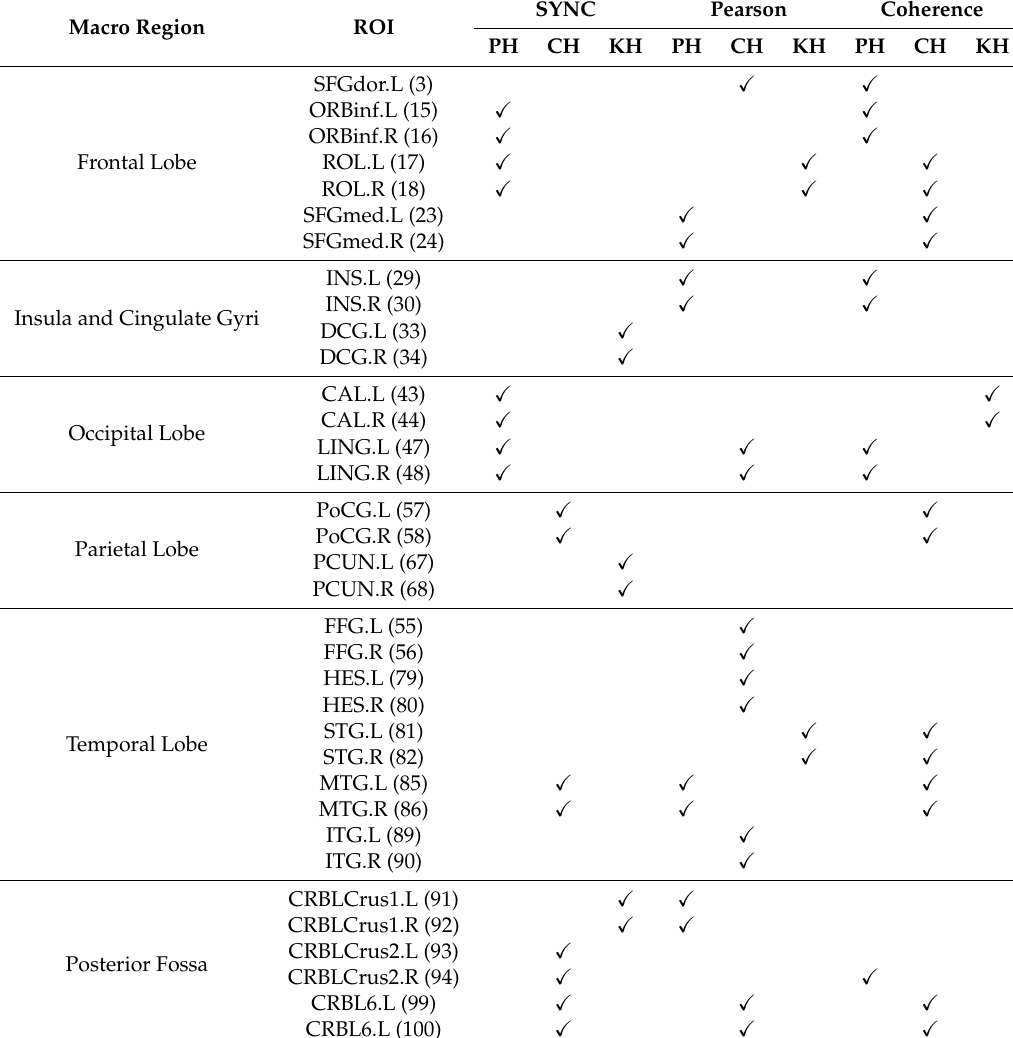
Figure 8. Upper percentile (75th) of the distribution of participation coefficient P for the three networks and all the fMRI sections. Table 1. Abbreviation of hub regions with the macro regions in which they are located and their roles for the three functional connectivity